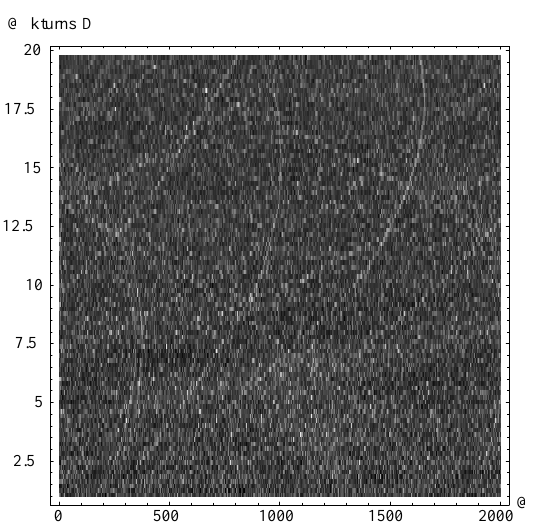
FIG. 4. 1.0 3 10 12 protons, one trace each 200 turns, vertical span 31.7 ms.